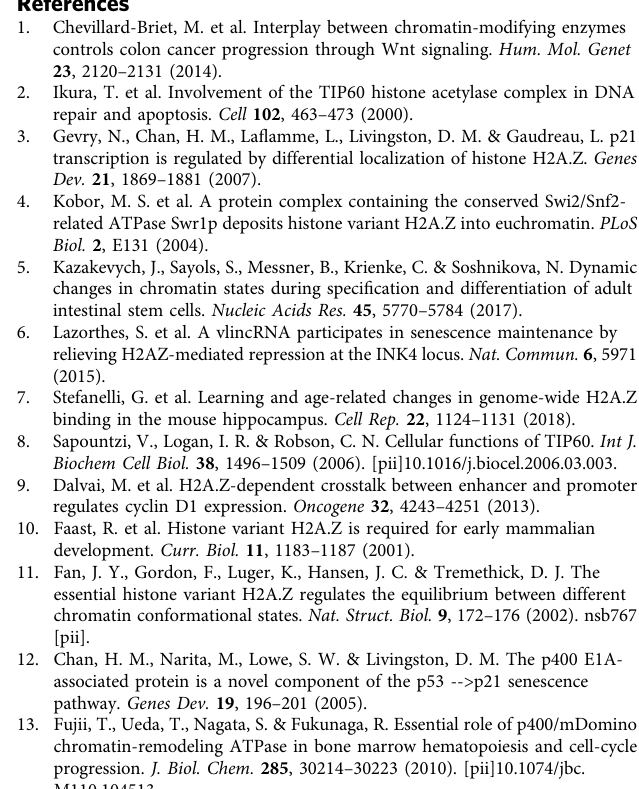
Supplementary Table 2 for sequences) or an H2A.Z expression vector (kind gift from Peter Cheung, University of Toronto, ON Canada) by electroporation (Amaxa) and analysis was performed 3 days after transfection. For proliferation assays, transfected cells were seeded in 96-well plates (2000 cells per well). Then at each day of the kinetics, cells were incubated with the cell proliferation reagent WST-1 (Sigma) for 2h at 37 °C, and cell numbers were measured by optical density at 450 nm. Caco-2/15 and HIEC cells were from the Jean-François Beaulieu ’ s lab (Université de Sherbrooke, Québec, Canada) and HCT116 were obtained from Patrick Calsou ’ s lab (IPBS, Toulouse, France). RT-qPCR and western blot analysis . Genotyping for H2afz alleles in intestinal epithelial samples was done by PCR analysis of DNA samples (see Supplementary Table 1 for primer sequences). For RT-qPCR, the RNA from cells or tissues was extracted using the RNeasy Kit (Qiagen) according to the manufacturer ’ s protocol, then it was reverse transcribed into cDNA using AMV reverse transcriptase (Promega). Finally quantitative PCR was performed using speci fi c primers (see Supplementary Tables 3 and 4), and β 2m was used as housekeeping gene. For western-blot, the proteins were extracted in lysis buffer (Triton X100 1%, SDS 2%, NaCl 150 mM, NaOrthovanadate 200 µM, Tris/HCl 50mM). The